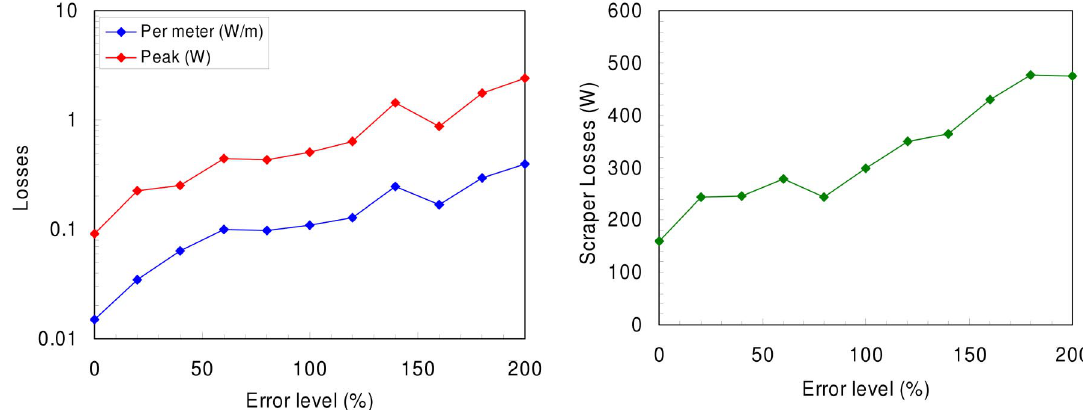
FIG. 10. (Color) The deuteron losses in the MEBT without the scraper and the deposited power on the scraper in respect to the error